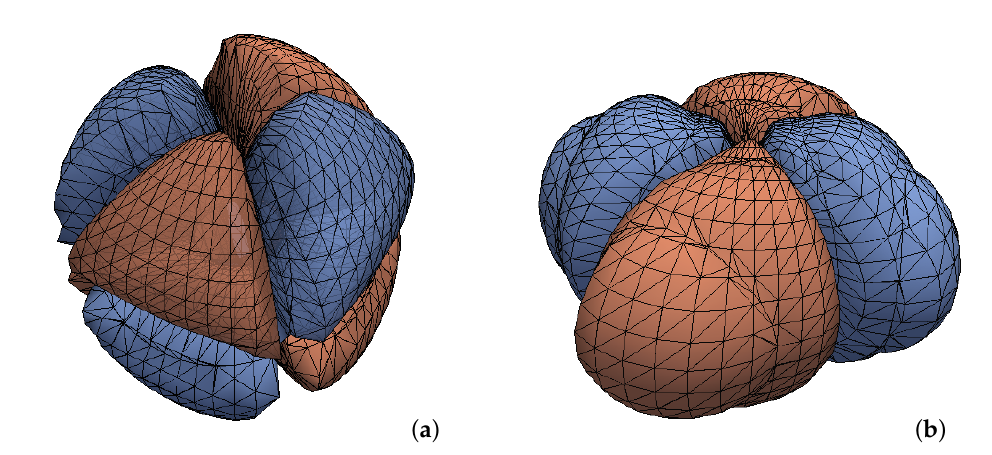
Figure 1. ( a ): Two Coulomb branch vorticity contours from the mass quadrupole according to Equation (5). The red and blue contours correspond to a pair of opposite vorticity values, with the red being + ve. ( b ): Coulomb branch vorticity contours from the current quadrupole given by Equation